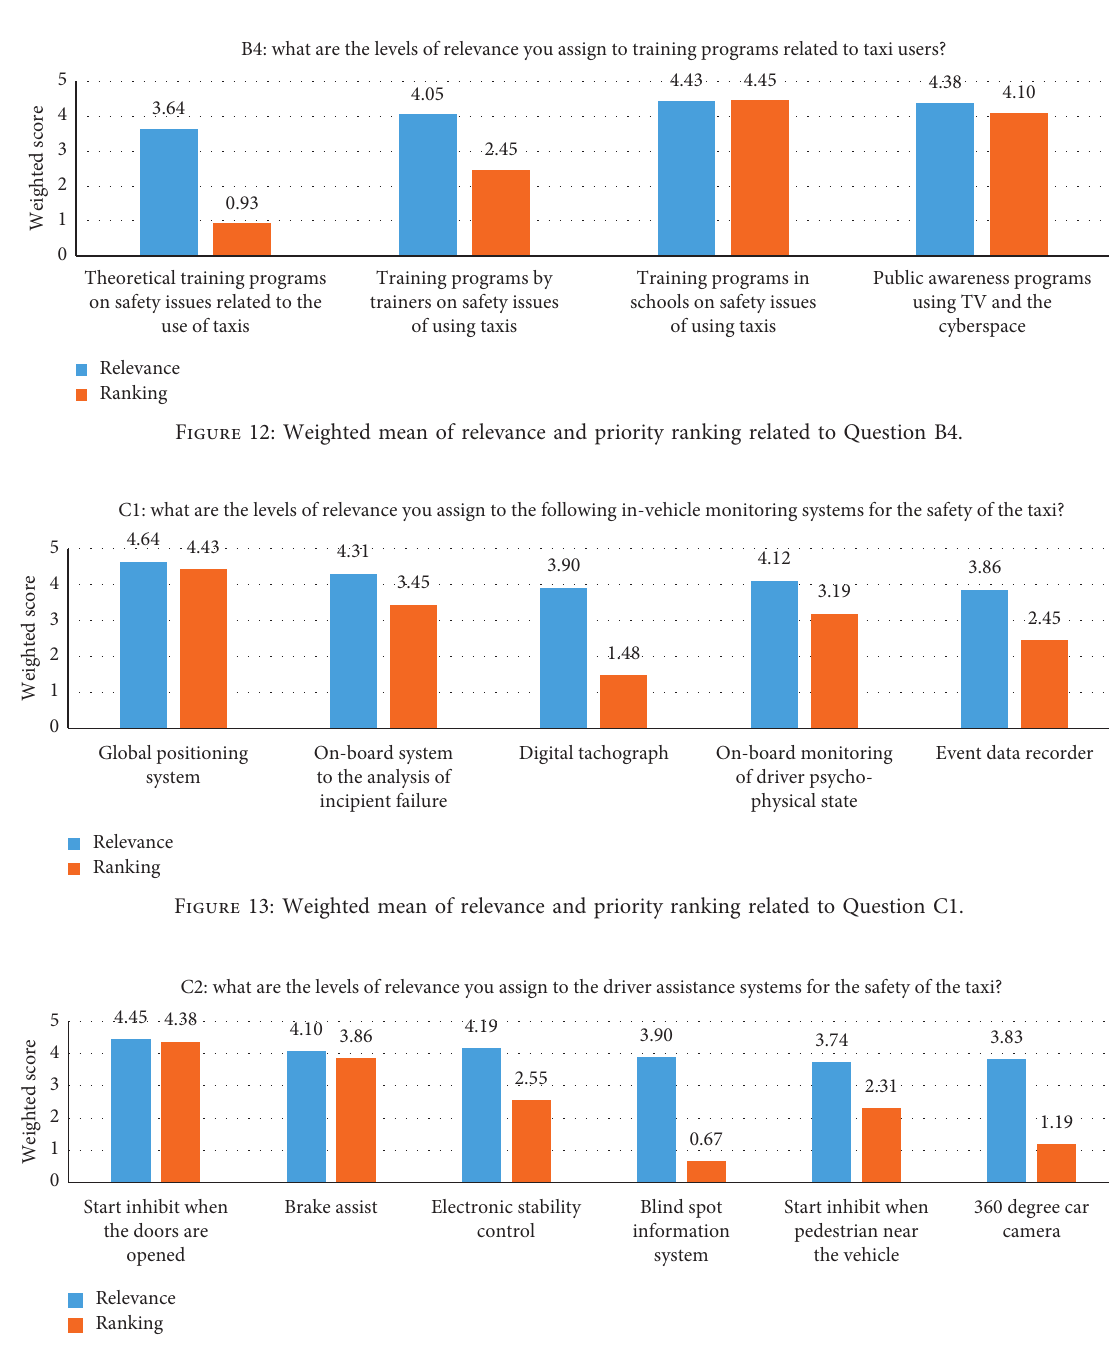
Figure 14: Weighted mean of relevance and priority ranking related to Question